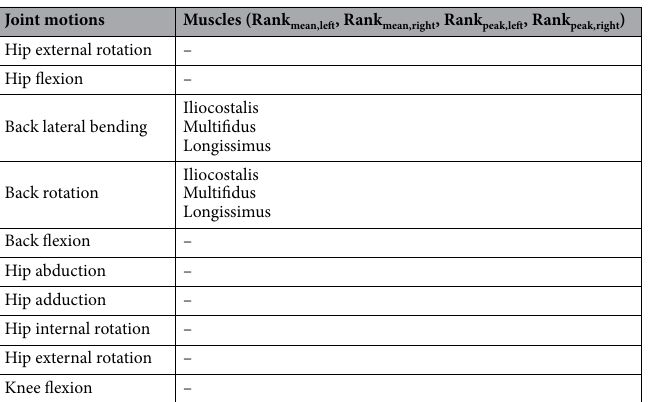
Table 5. A relationship between the potential stressful joint motions with their associated muscles.